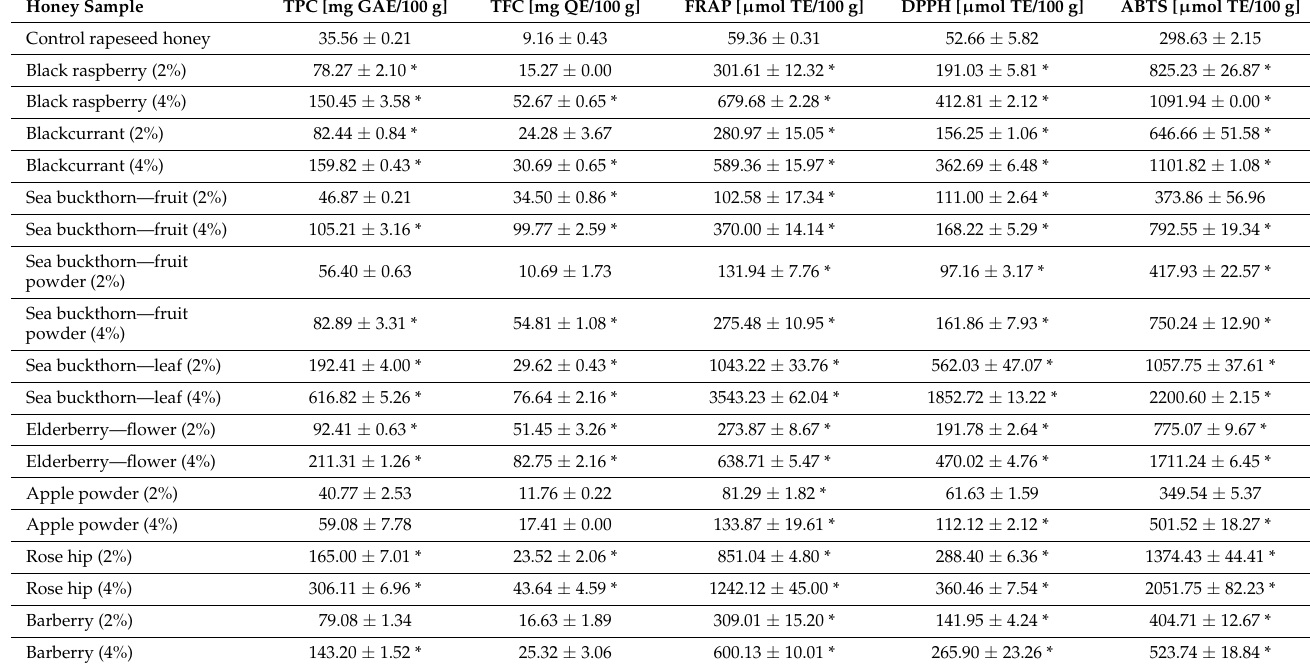
Table 1. Phenolic compounds content and antioxidant capacity of plant-flavored honeys (fresh